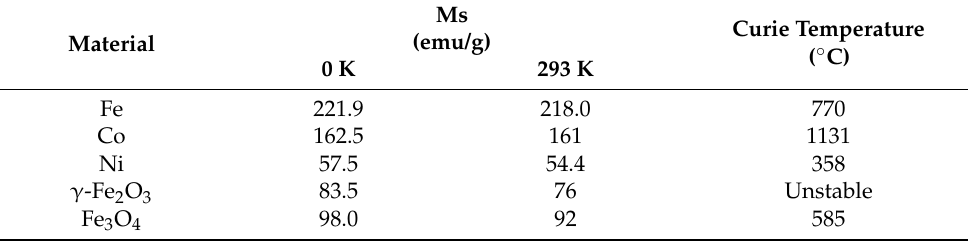
Table 1. Saturation magnetization (Ms) and Curie Temperature for various materials